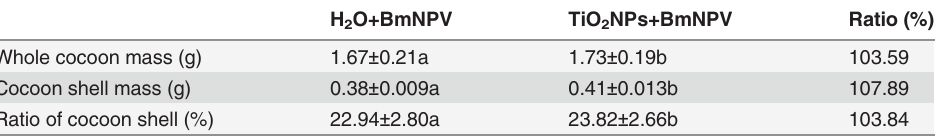
Table 3. Effect of TiO 2 NPs on cocoon quality after BmNPV